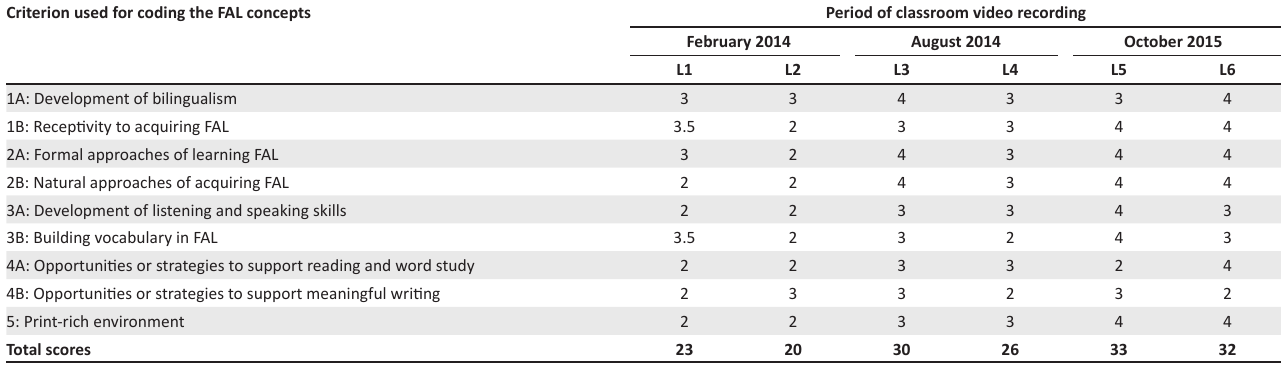
TABLE 4: The extent to which Lisa’s practice reflects the principles of teaching English as a First Additional Language. Criterion used for coding the FAL